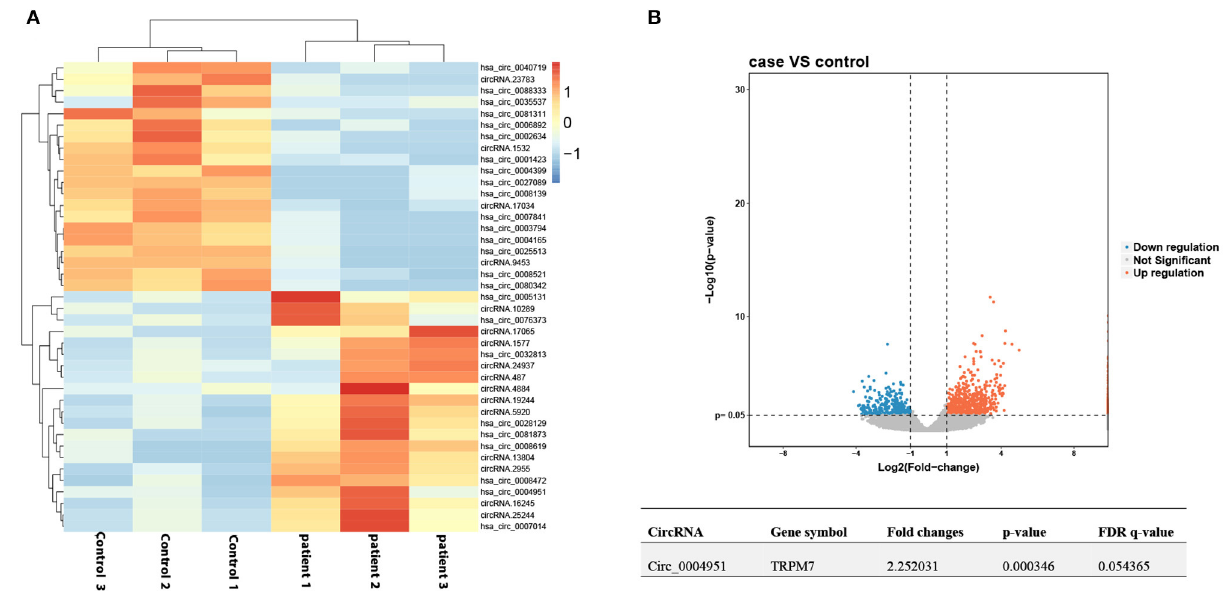
Circ_0004951 Is Upregulated in Renal Tissues of DKD Patients Circ_0004951 was significantly upregulated in renal tissue samples of DKD patients ( n = 6) relative to normal renal tissues ( n = 6; Figure 2A ). Amplification of the RNA from renal tissue of patients with DKD using divergent primers revealed presence